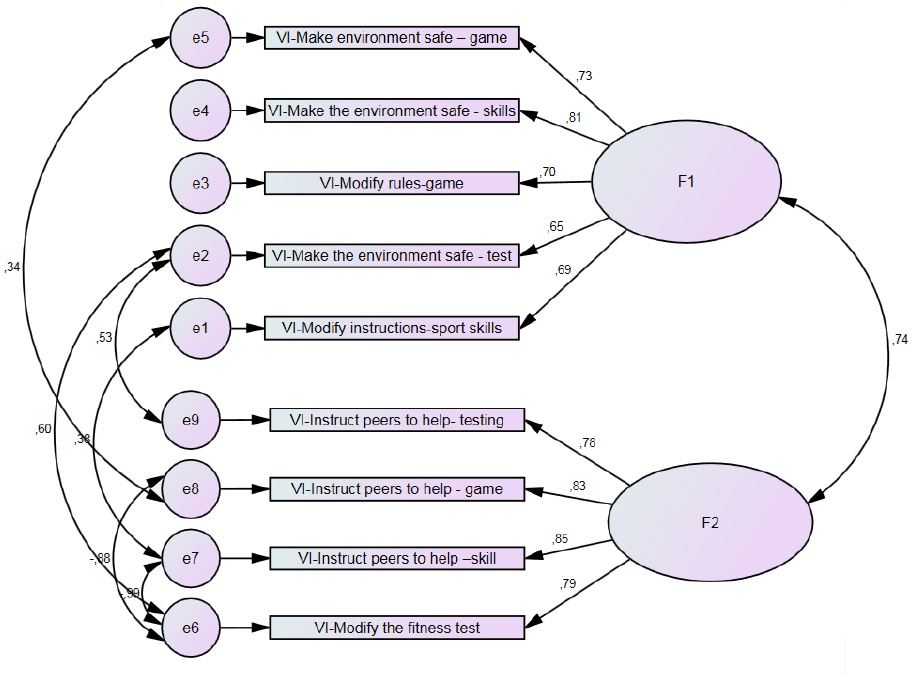
Figure 3. Path diagram of visual impairment